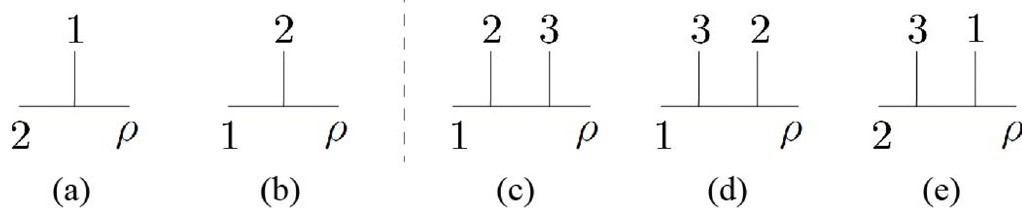
Figure 14 . Graphs (a) and (b) are the cubic diagrams corresponding to numerators N ρ (2 , 1) and N ρ (1 , 2) which are related with each other by antisymmetry. Numerators N ρ (1 , 2 , 3) , N ρ and N ρ (1 , 3 , 2) that are respectively characterized by (c), (d) and (e) are related via Jacobi identity. A and the rightmost elements in the off-shell extended BCJ numerators N ρ (1 , σ ) ≡ N ρ